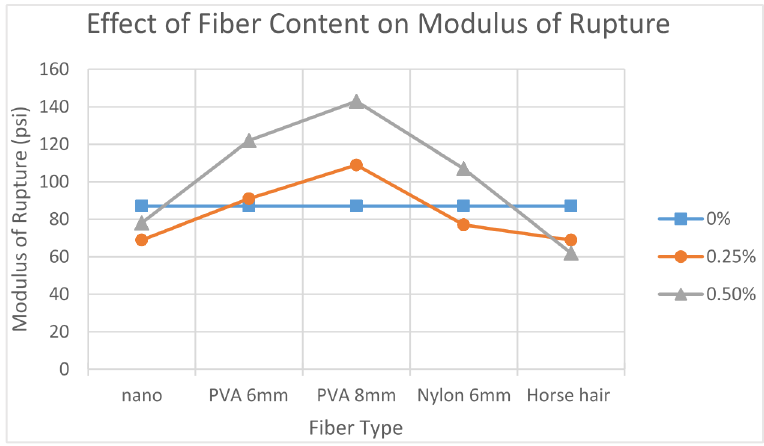
Figure 3. Effect of fiber content on the modulus of rupture for different types of fibers.